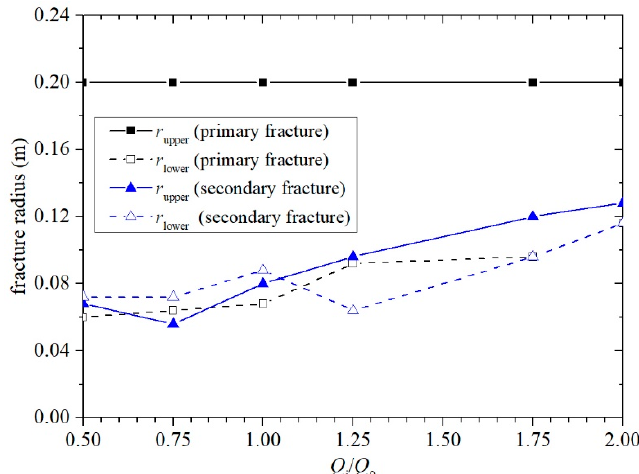
Figure 17. The fracture radius of models with different inlet flux when the primary fractures reach the boundary.